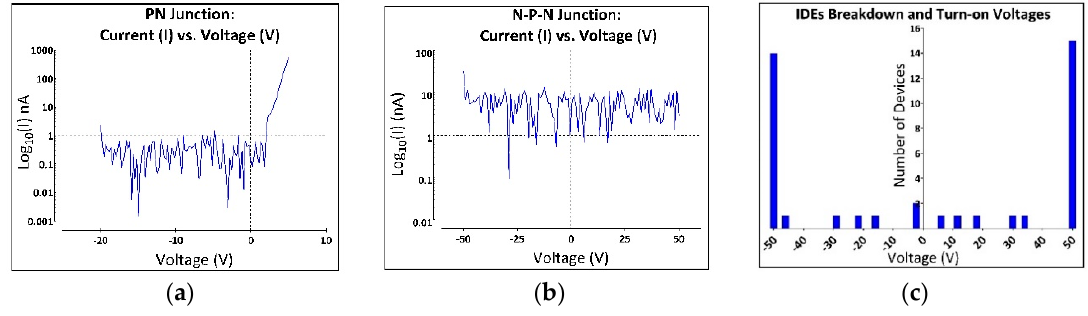
Figure 2. All-SiC device electrical characterization. The electrical properties of the device were first tested by performing current vs voltage (IV) measurements on the fabricated test structures. ( a ) IV measurements were performed over a range of − 20 V to 5 V on the p-n diodes post fabrication. The results, shown on a semi-log plot, demonstrate a typical forward-biased turn-on voltage of ~2.3 V and a leakage current well below 1 nA out to − 20 V. ( b ) Conductive trace mesa isolation measurements via IV sweeping from − 50 to 50 V in air. Note that the long p-n junctions provided excellent isolation with a slight current leakage of less than 7.5 nA rms over the measured voltage range. ( c ) Histogram from the insulation/isolation measurements performed on 20 IDE structures of Figure 1b. IV characterization for 20 IDE devices were taken from − 50 V to 50 V. Of the 20 devices, only 2 showed significant current flow at the p-n junction’s turn-on voltage ( − 2.3 V), while 4 IDEs showed current flow at cathodic potentials between − 16 V to − 50 V and the remaining 14 continued to block to at least − 50 V. Under reverse bias conditions, 5 IDEs experienced leakage current between 6 V to 35 V, while the remaining 15 continued to block up to 50